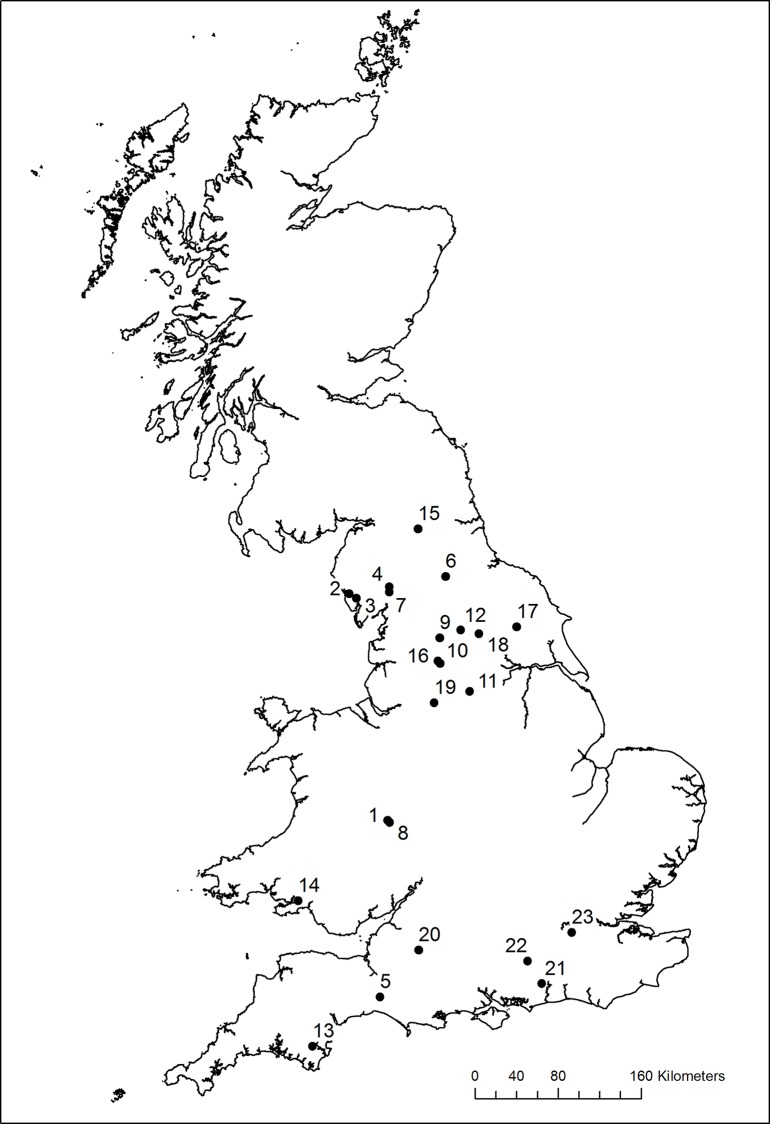
Locations of the 23 HEP schemes with spatially and temporally co-located fish monitoring data.Reprinted from Ordnance Survey (Digimap Licence) under a CC BY license, with permission from Crown Copyright and Database Right [2016].